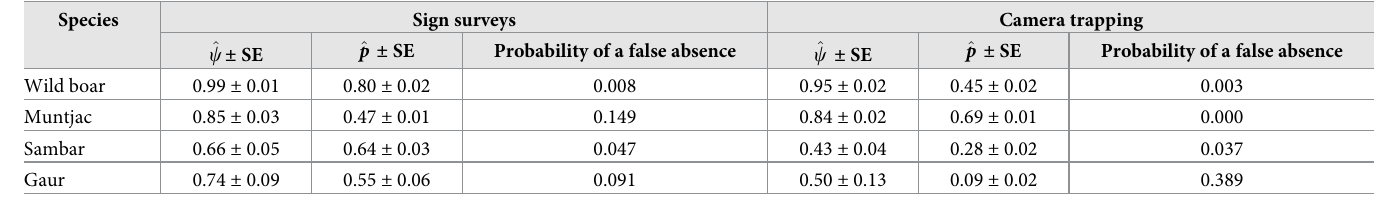
Table 3. Occupancy ( ^ c ) and detection probability ( ^ p ) estimates with corresponding standard errors (SE) from the constant model ψ (.) p (.) and probability of a false absence with the use of sign surveys and camera trapping for ungulates from all combined sites in Temengor Forest Reserve and Royal Belum State Park. Species Sign surveys Camera